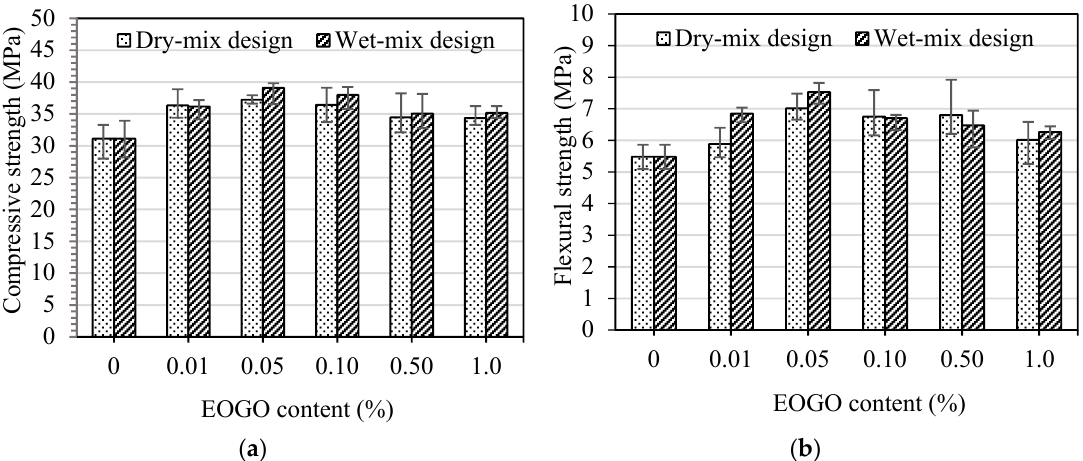
Figure 9. Comparison between the dry and wet-mix design methods of EOGO-cement pastes: ( a ) Compressive strength at 28 days and ( b ) flexural strength at 28 days.